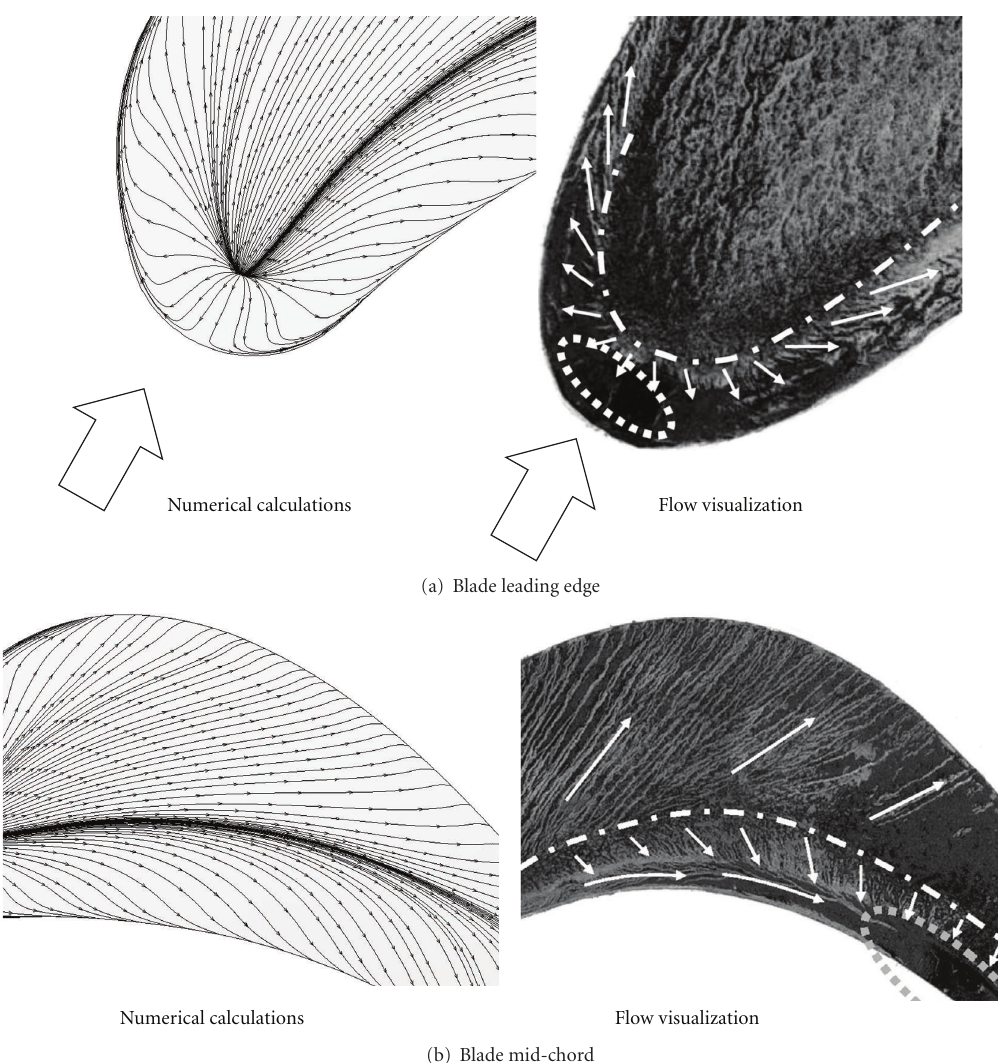
Figure 12: Tip surface flow